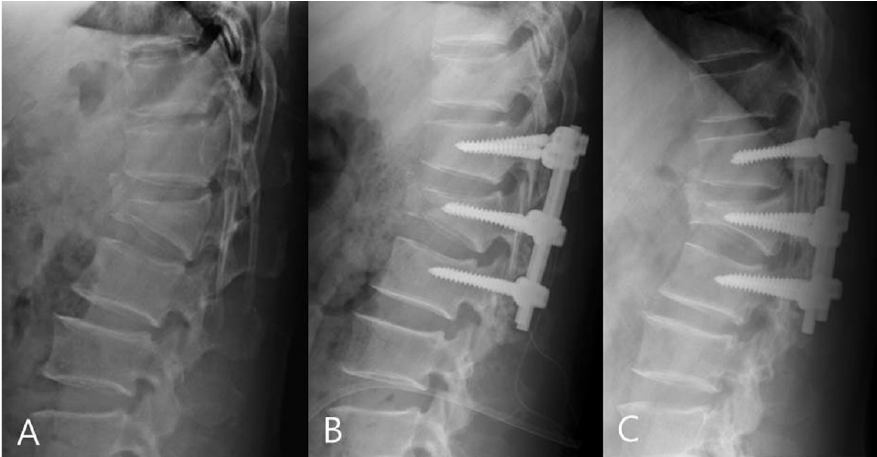
Figure 4. ( A ) 45-year-old male patient with L1 burst fracture was treated by poly-axial pedicle screw fixation. ( B ) Postoperative imaging showed a mild correction of anterior body height and kyphosis. ( C ) Final follow-up imaging showed correction loss.